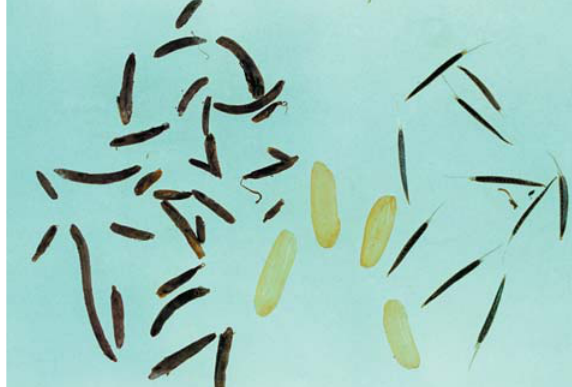
FIG. 10 Variation in size and shape of Claviceps cyperi sclero- tia (left) in comparison with rice grains (centre) and Tagetes minuta , khaki bush, seeds